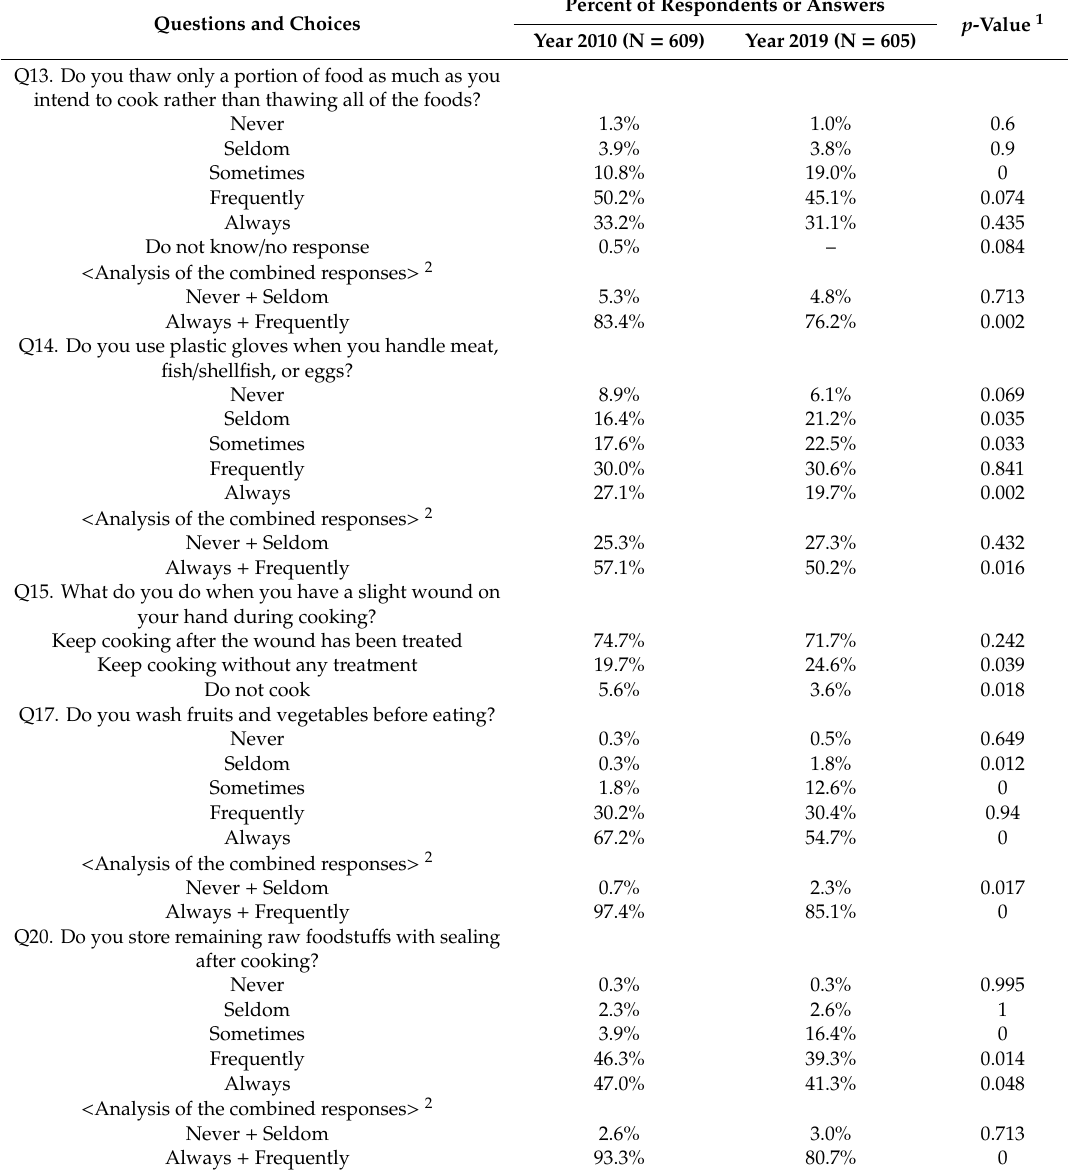
Table 5. Consumer behaviors for food purchasing, preparing, cooking, eating, leftovers management, and kitchen